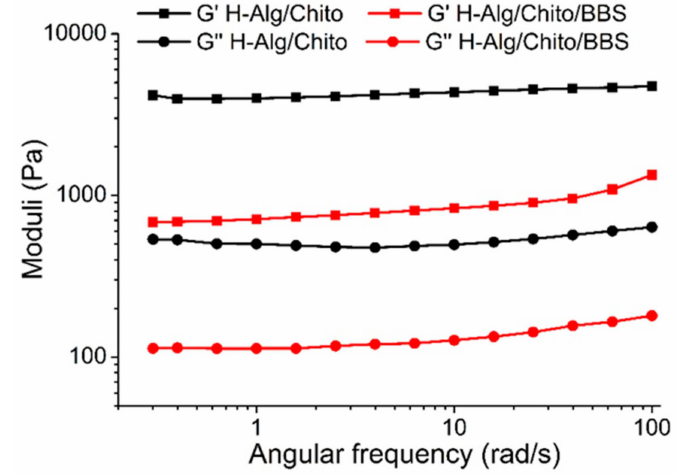
Figure 6. Rheological measurements with indications of the storage G’ (squares) and loss G” (circles) moduli for H-Alg / Chito (black line) and H-Alg / Chito / BBS (red line).